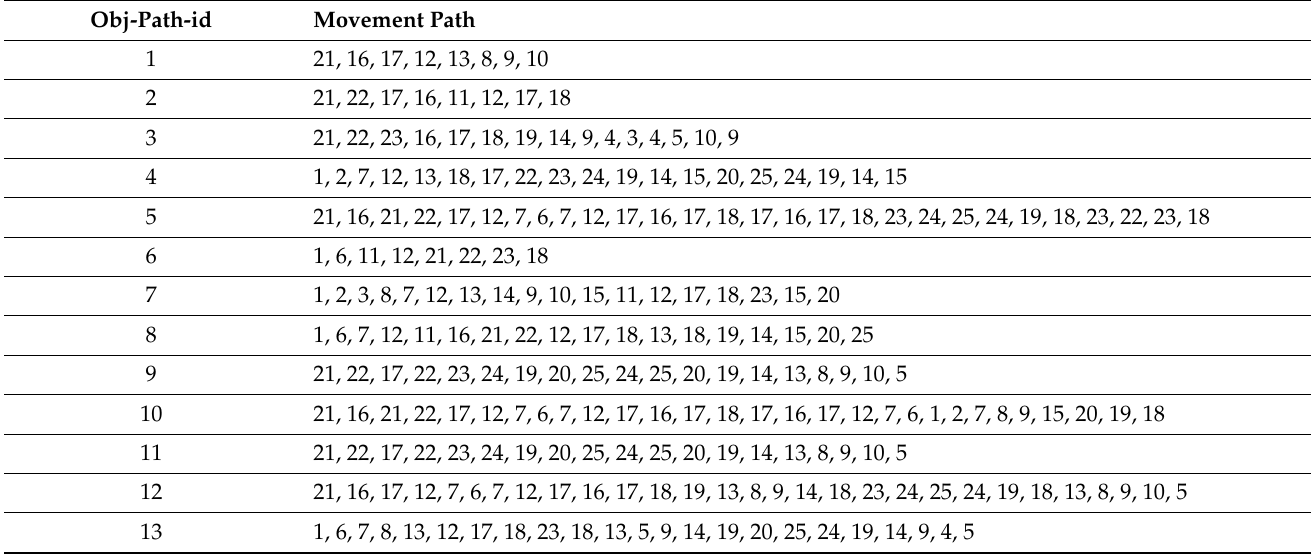
Table 2. Example of the structure of the target movement log.